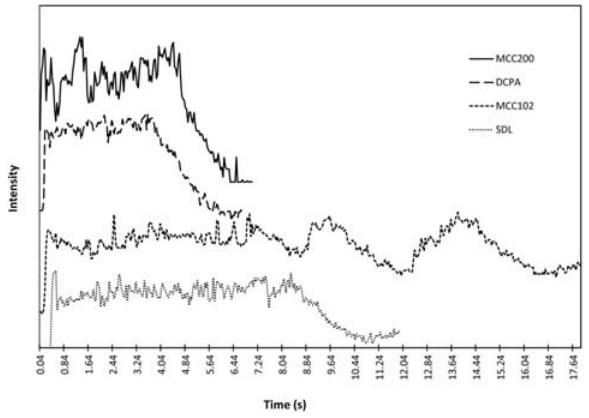
Figure 7. Intensity profiles of spatial-temporal images for all tested materials: dicalcium phosphate anhydrous (DCPA), microcrystalli- ne cellulose MCC102 and MCC200, and spray-dried lactose (SDL). Each peak corresponds to one detachment event: intensity is presented on Y axis without units for purpose of improved illu-